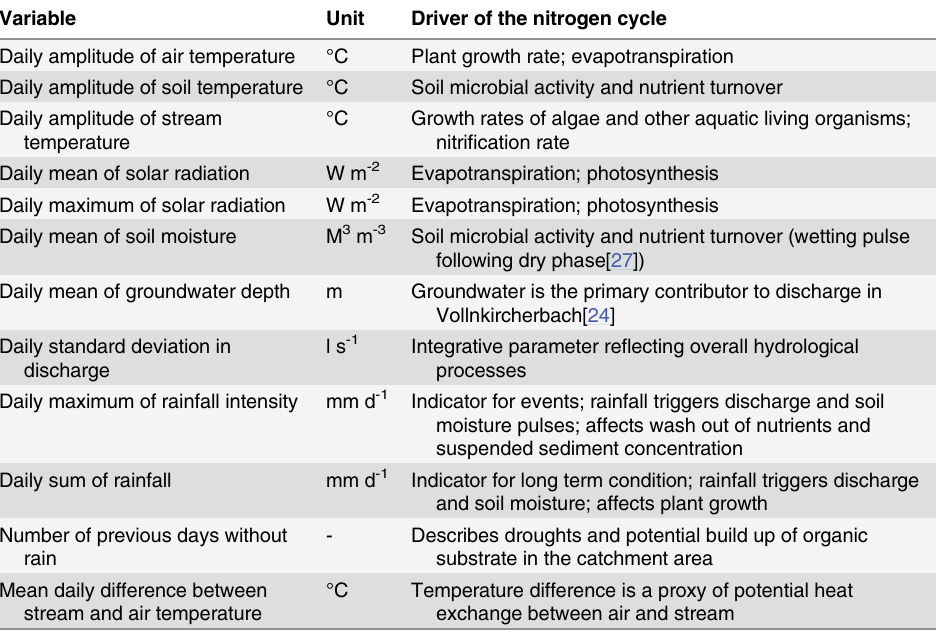
Table 1. Variables potentially driving the in-stream nitrate cycle, or potential drivers. Variable Unit Driver of the nitrogen cycle Daily amplitude of air temperature °C Plant growth rate; evapotranspiration Daily amplitude of soil temperature °C Soil microbial activity and nutrient turnover Daily amplitude of stream temperature Daily mean of solar radiation Evapotranspiration; photosynthesis